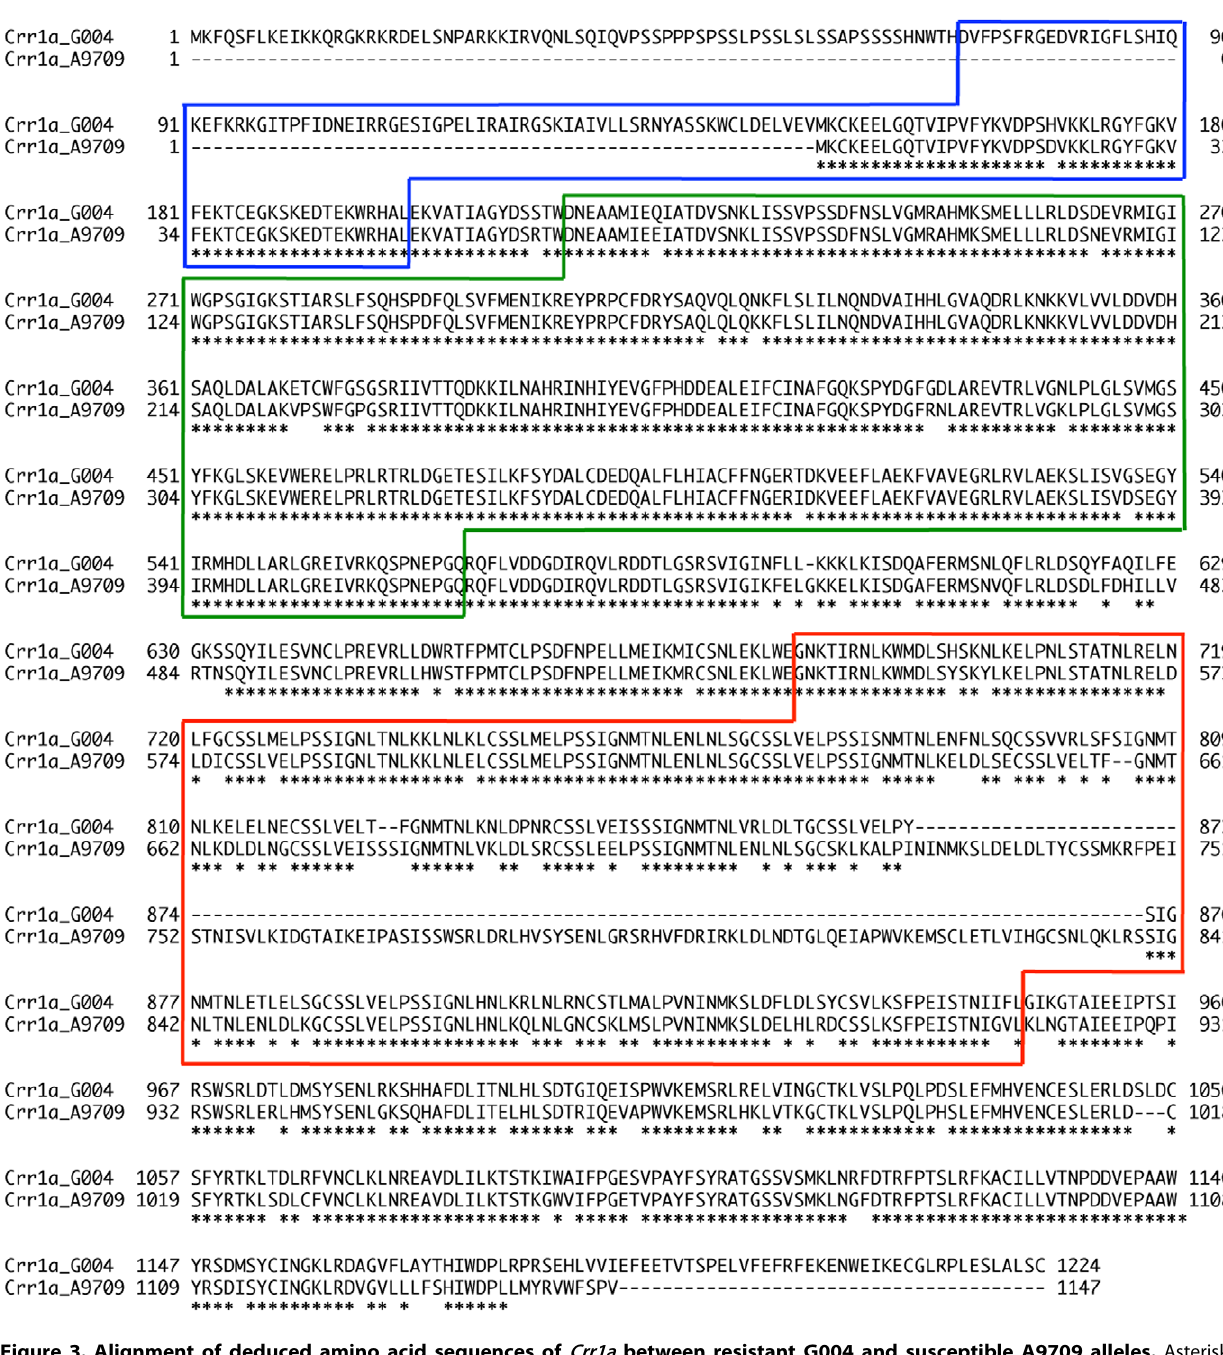
Figure 3. Alignment of deduced amino acid sequences of Crr1a between resistant G004 and susceptible A9709 alleles. Asterisks, identical amino acid residues; dashed lines, gaps for alignment. Blue, TIR domain; green, NB domain; red, LRR domain.